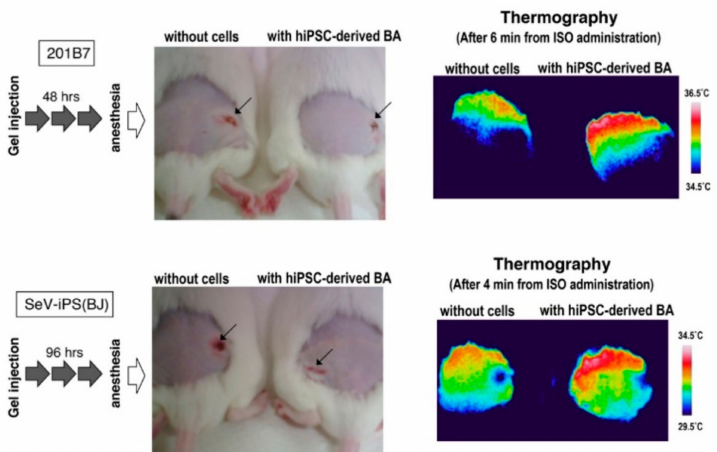
Figure 9. Human-induced pluripotent stem cells (hiPSC)-derived BAs produce heat in vivo in response to adrenergic stimuli. BAs were generated from two lines of hiPSCs, 201B7 (upper) and SeV-iPS(BJ) (lower) by the cytokine-free method and subcutaneously transplanted after embedded in fibrin gel. Without isoproterenol, there was no significant di ff erence in the dermal temperature between BA-transplanted and sham-operated mice regardless of the time after transplantation. After an administration of isoproterenol, however, the dermal temperature was specifically up-regulated in BA-transplanted